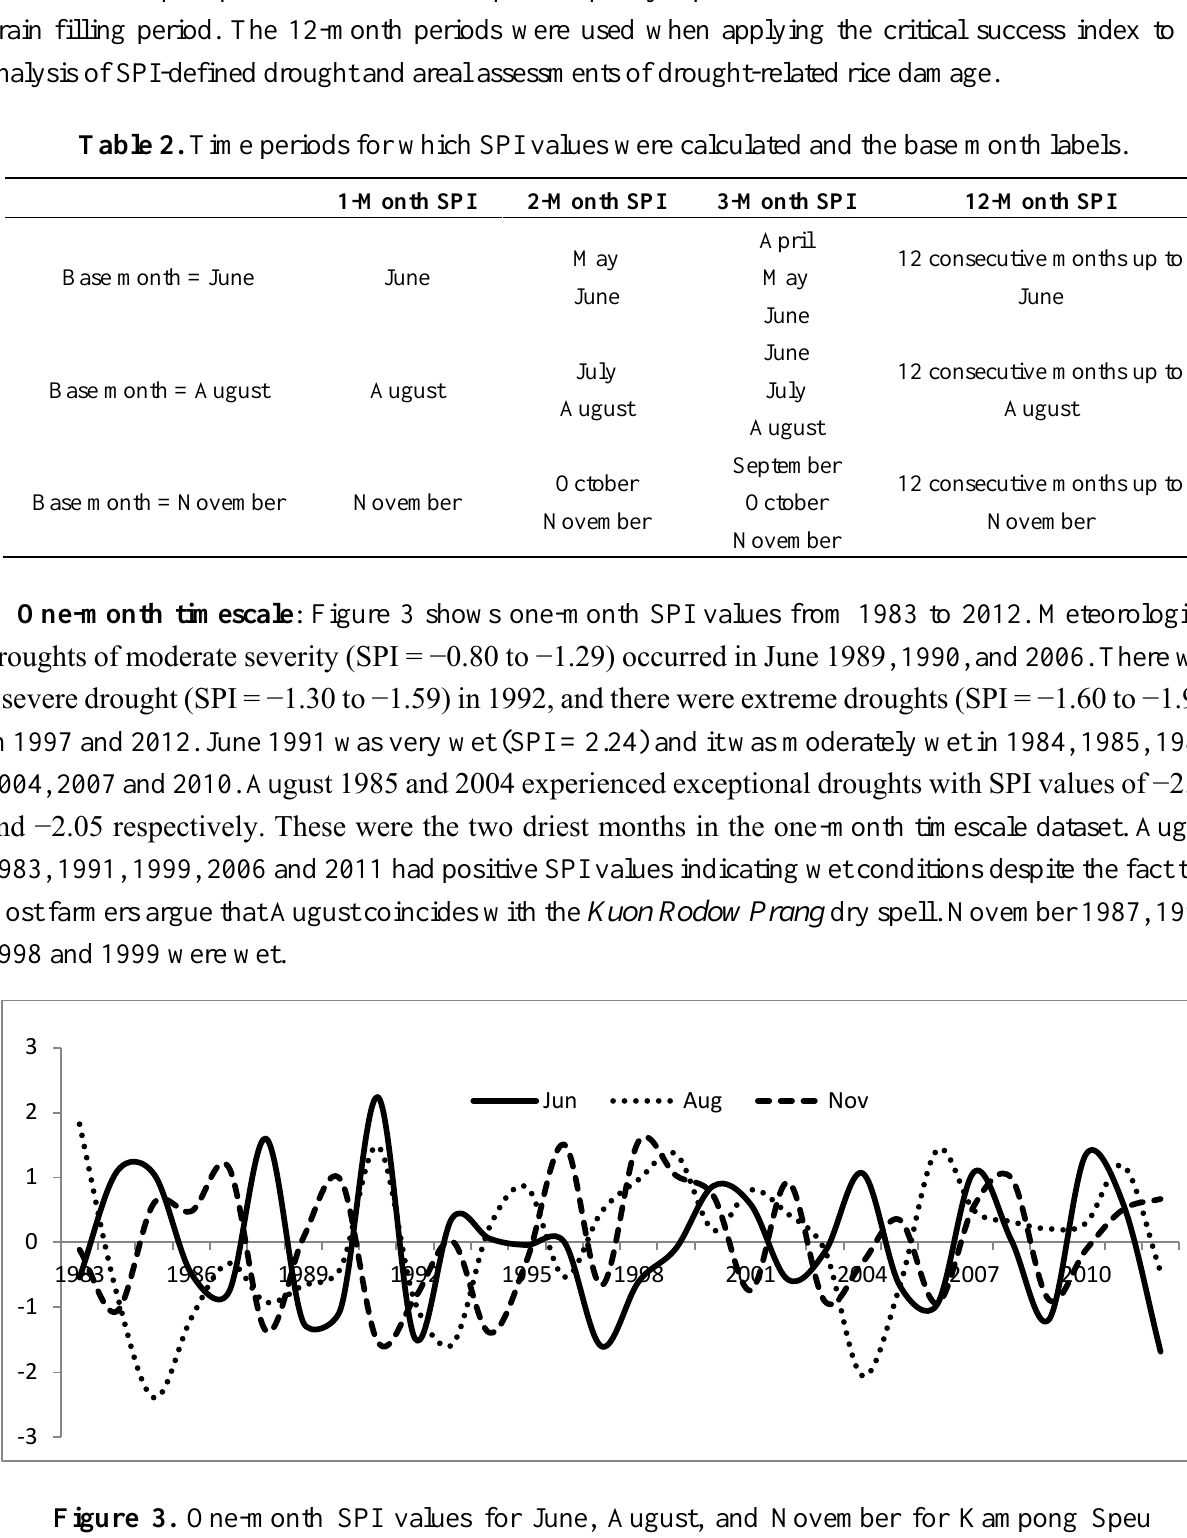
Figure 3. One-month SPI values for June, August, and November for Kampong Speu station,